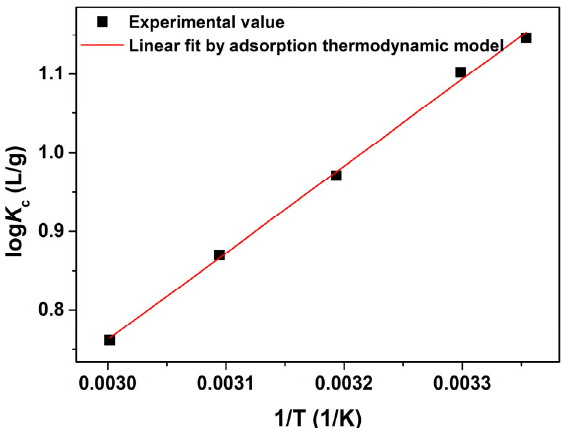
Figure 10. Experimental data from the adsorption of AO7 onto porous CeO 2 fitted using the Van’t Hoff equation ([CeO 2 ] = 2.0 g/L; [AO7] = 150 mg/L; V = 100 mL; t = 60 min; 200 rpm; Room temperature; No pH preadjustment). Table 2. Thermodynamic parameters for the adsorption of AO7 onto porous CeO 2